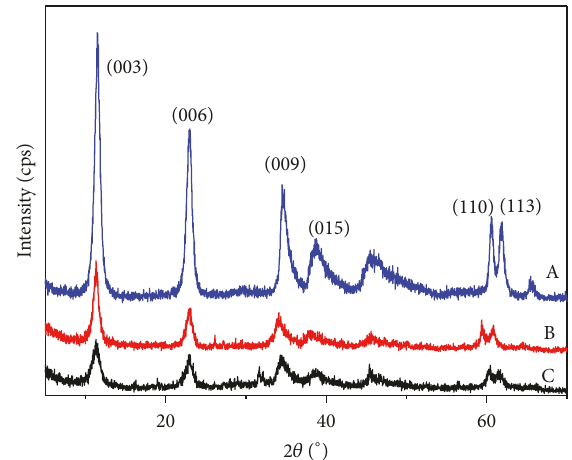
Figure1:XRDpatternsofLDHssamples(A:MgAl-LDHs,B:MgFe- LDHs, and C: MgAlFe-LDHs).